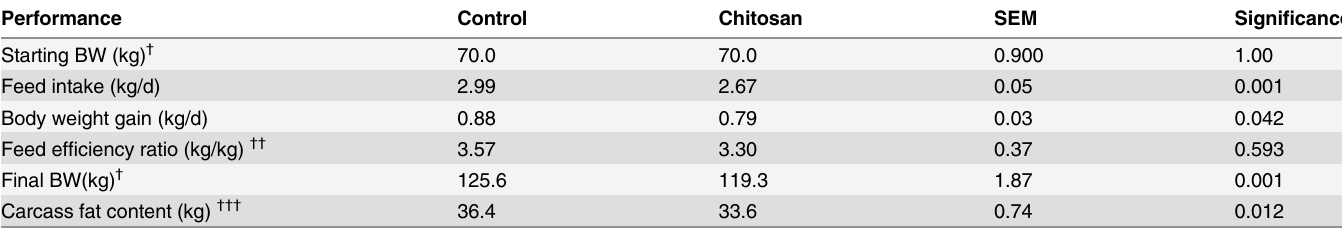
Table 3. Effect of dietary supplementation on growth performance and carcass characteristics (least-square means and SEM). Performance